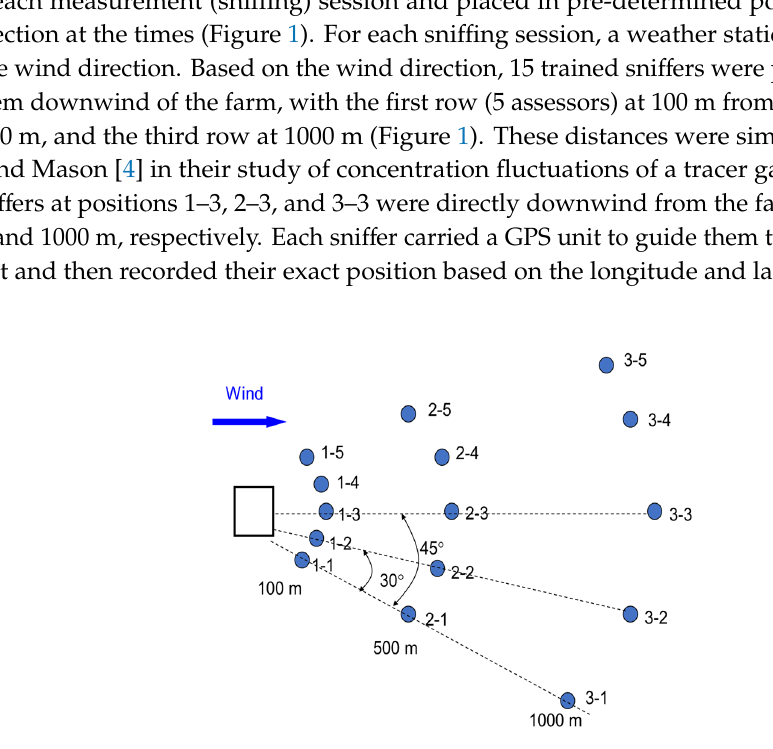
Figure 1. Grid for odour measurement in the field, with the positions of 15 human assessors denoted as 1–1 to 3–5 at 0 ° , 30 ° , and 45 ° from the wind direction at 100, 500, and 1000 m from the odour source.